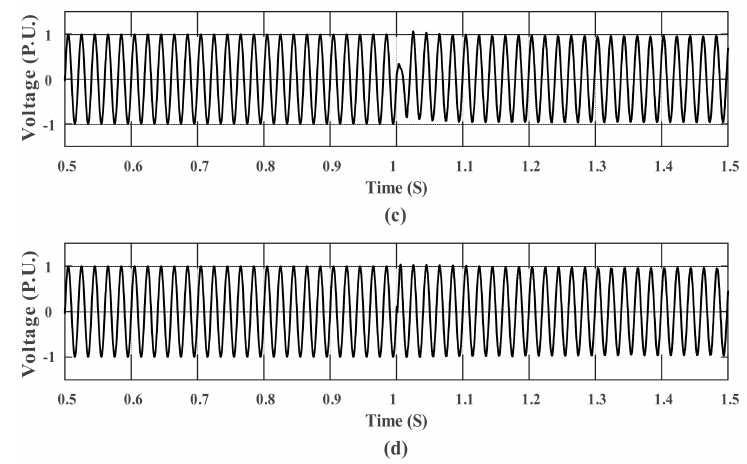
Figure 13. Simulation results of unplanned outage transition: ( a ) Main grid currents without the proposed method; ( b ) Main grid currents with the proposed method; ( c ) MG voltage without the proposed method ( d ) MG voltage with the proposed method.